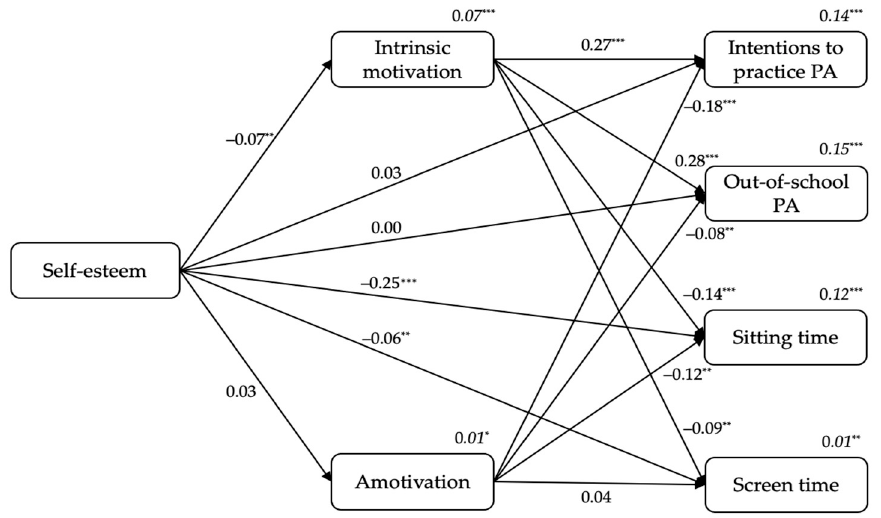
Figure 5. The standardized coefficients from students’ self-esteem to intrinsic motivation and amotivation, and to outcomes. Note . * p < 0.05. ** p < 0.01. *** p < 0.001.